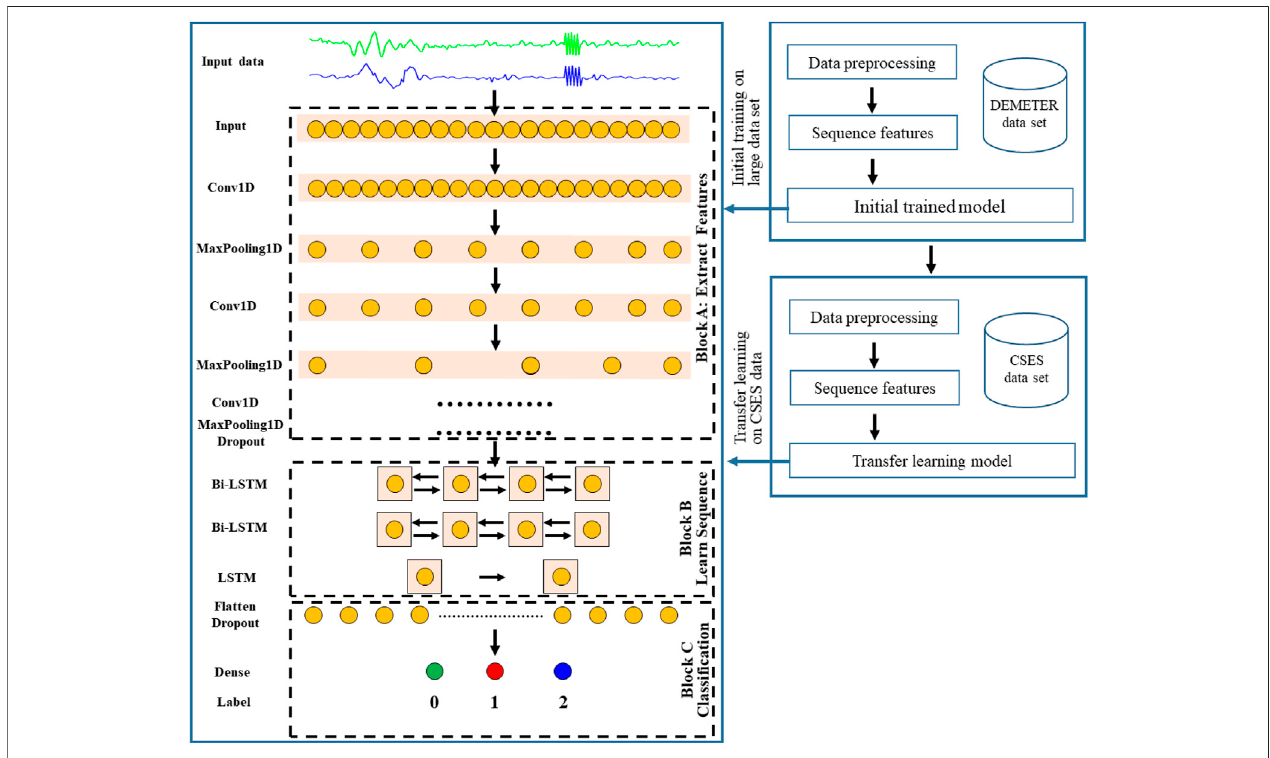
FIGURE 2 | Generalized model architecture of SeqNetQuake and the transfer learning process. Conv1D: 1-D convolutional neural network; MaxPooling1D: 1-D max-pooling layer; Dropout: drop-out layer; Bi-LSTM: bidirectional long short-term memory layer. “ Flatten ” and “ Dense ” are the names of the functional layers.